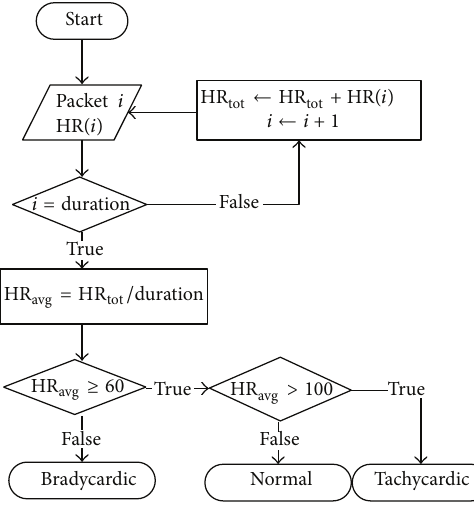
Figure 3: Sinus rhythm classification block